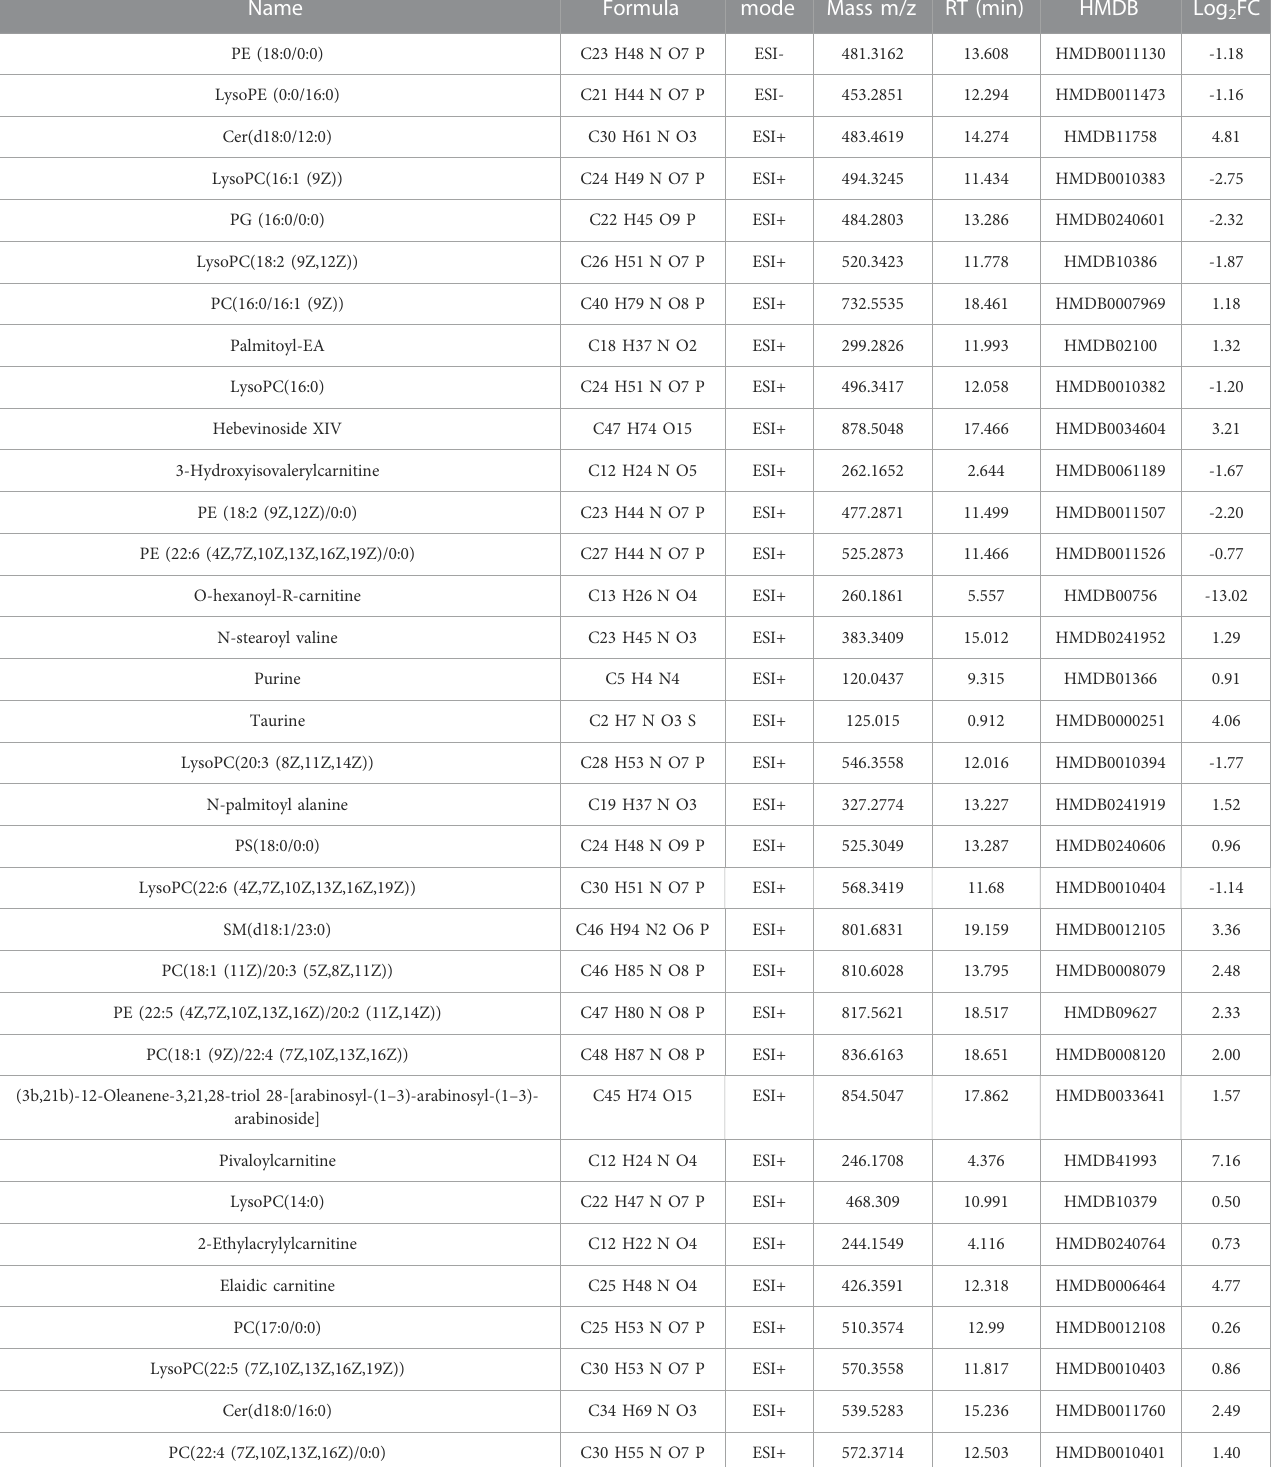
TABLE 5 Differential metabolites in rat cardiac tissue associated with chronic heart failure ( p <